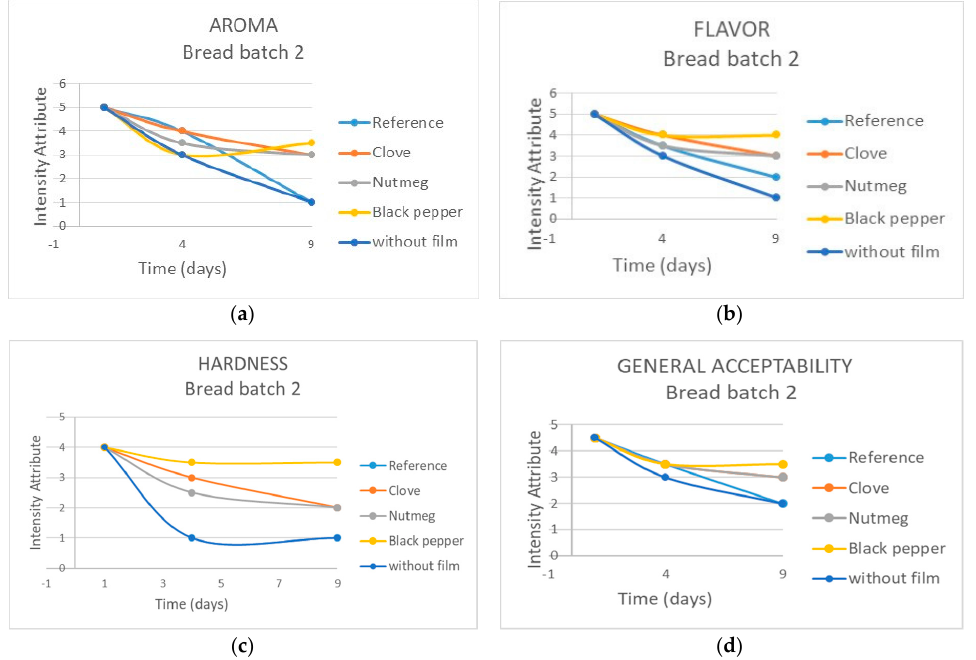
Figure 11. Evolution of sensory attributes during nine days of storage (25 °C and 75% RH) of bread packaged in biocomposite films. ( a ) Aroma; ( b ) flavor; ( c ) hardness; ( d ) general acceptability.